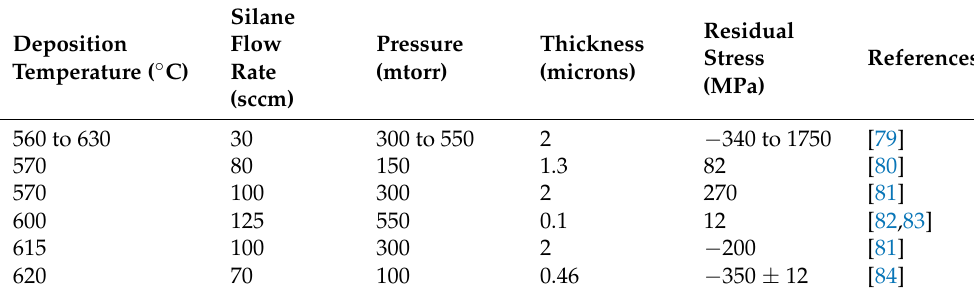
Table 2. Residual Stresses in As-Deposited, Undoped LPCVD Polysilicon.